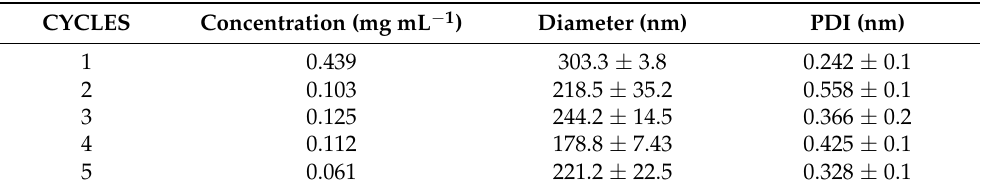
Table 8. Yield and size of MIP nanoparticles after five successive cycles and elution using Tween 20. For the measurements of size, PDIs were included.